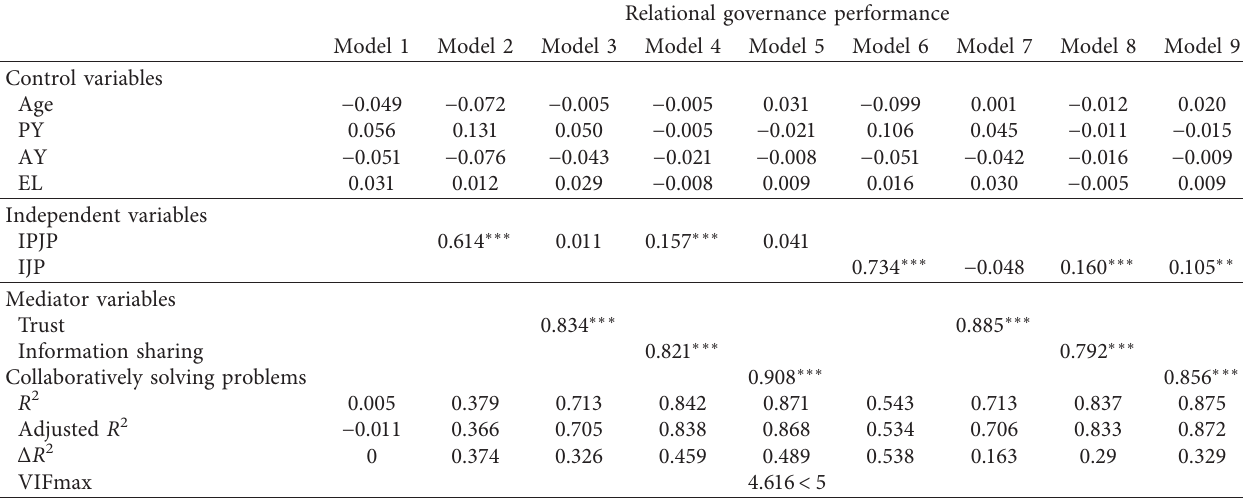
Table 6: Regression analysis results of mediating effects of relational